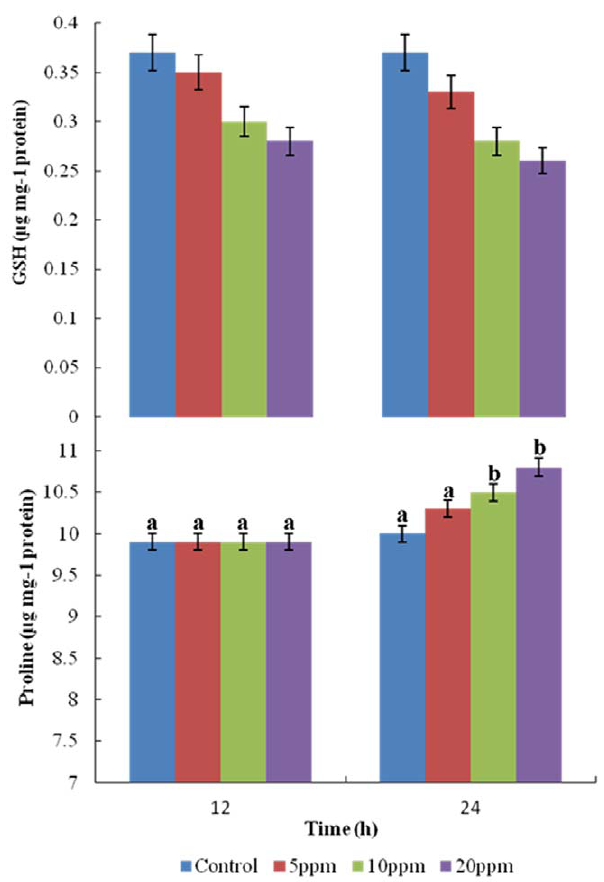
Figure 4. Effect of anilofos (mg L 2 1 ) on GSH and Proline content of Synechocystis sp. strain PUPCCC 64. All presented data are the mean values of three independent experiments 6 SD Data at different time intervals with same lower case letters are not significantly different from each other at the 95% confidence level (p , 0.05).